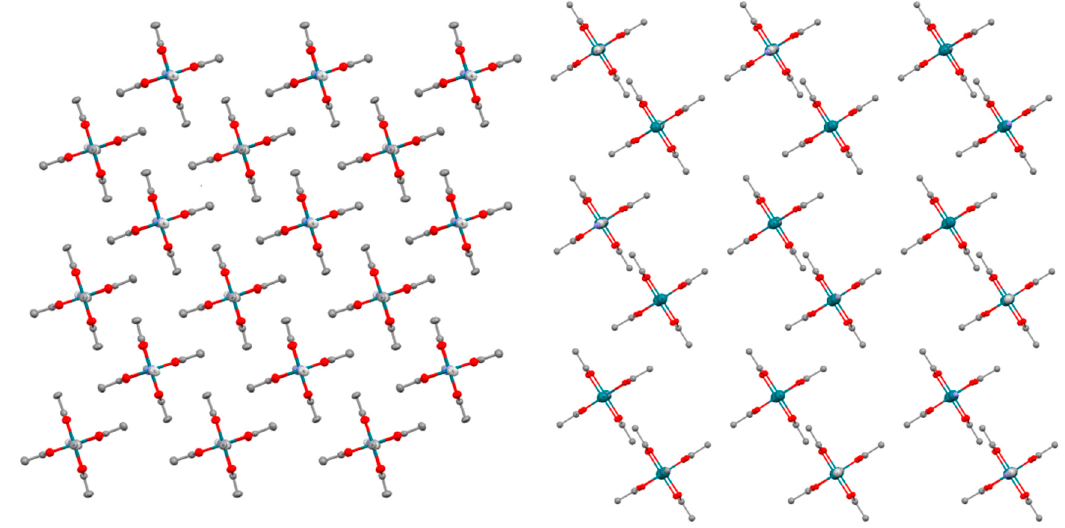
Figure 4. View of the chains that form 3a along the b axis in a 3 × 3 × 3 cell packing ( left ). View of the chains that form 3b along the a axis in a 3 × 3 × 3 cell packing ( right ). Hydrogen atoms are omitted for clarity.